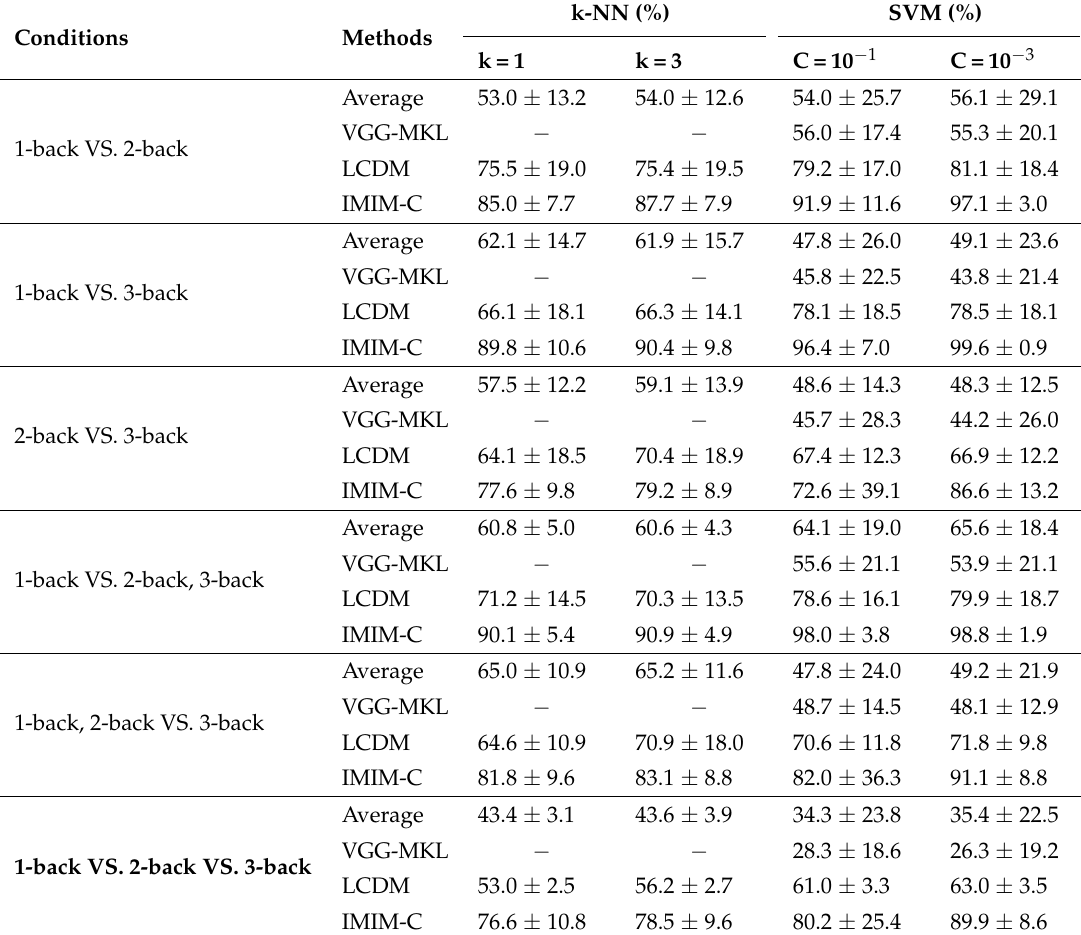
Table 5. Comparison of the classifier level fusion methods based on SVM (C = 10 − 1 , C = 10 − 3 ) and k-NN (k = 1, k = 3) for mental workload estimation. 6 pairs of mental workload conditions (1-back VS 2-back, 1-back VS 3-back, 2-back VS 3-back, 1 and 2-back VS 3-back, 1-back VS 2 and 3-back, 1-back VS 2-back VS 3-back) are used to compare the ability of the methods to classify the mental workload levels in 1-, 2-, 3-back tasks. VGG-MKL is a multi-kernel learning algorithm based on